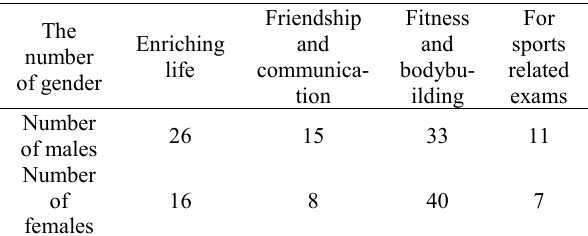
Table 7 Motivation to participate in extracurricular